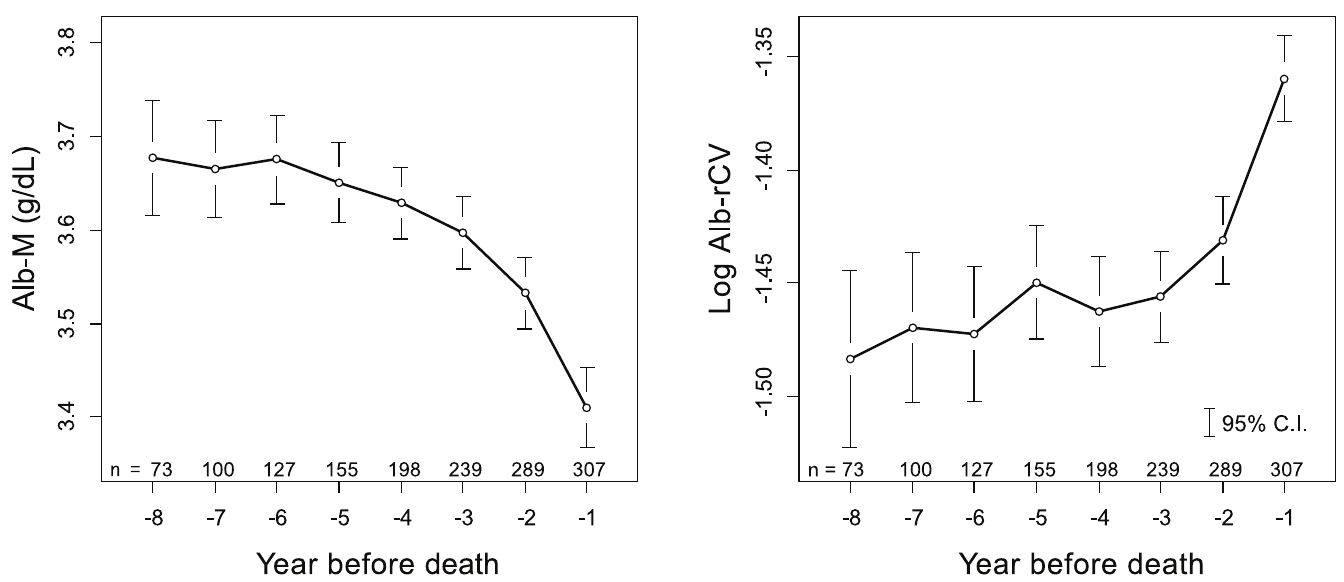
Fig 3. Yearly trend in albumin levels and variability prior to death. IndividuallycalculatedAlb-M and log Alb-rCV values were averagedand plotted for the year before death. The vertical bars represent the 95% confidenceintervals. The numberof eligiblesubjects in each year is labeledin the figure.